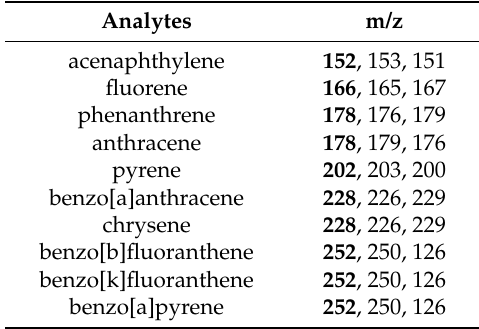
Table 1. The m/z values used for the determination of PAHs by GC-MS (values in bold were used for the quantification of the